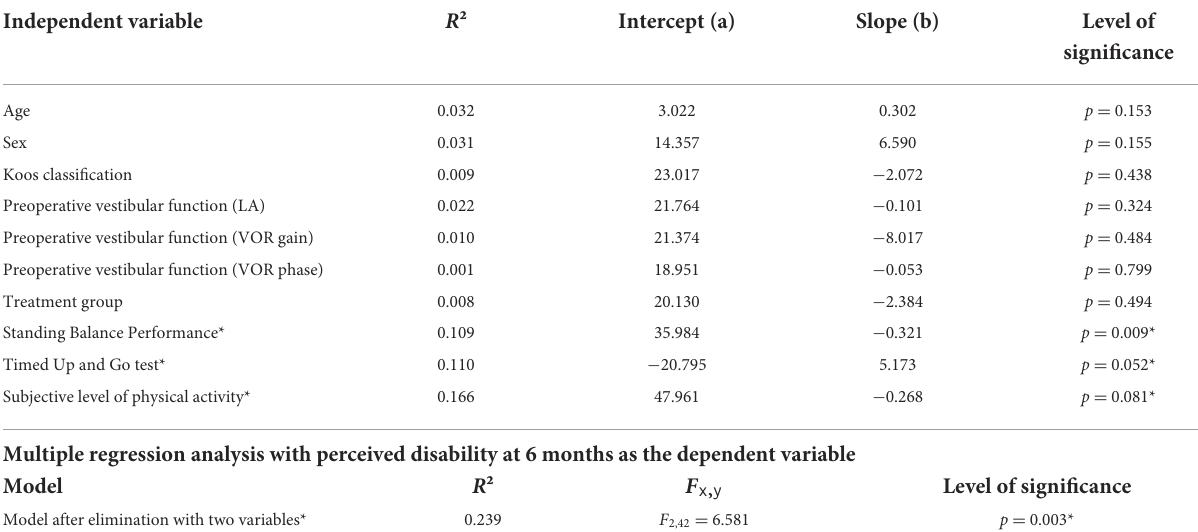
TABLE 3 Predictive factors for perceived disability due to dizziness at 6